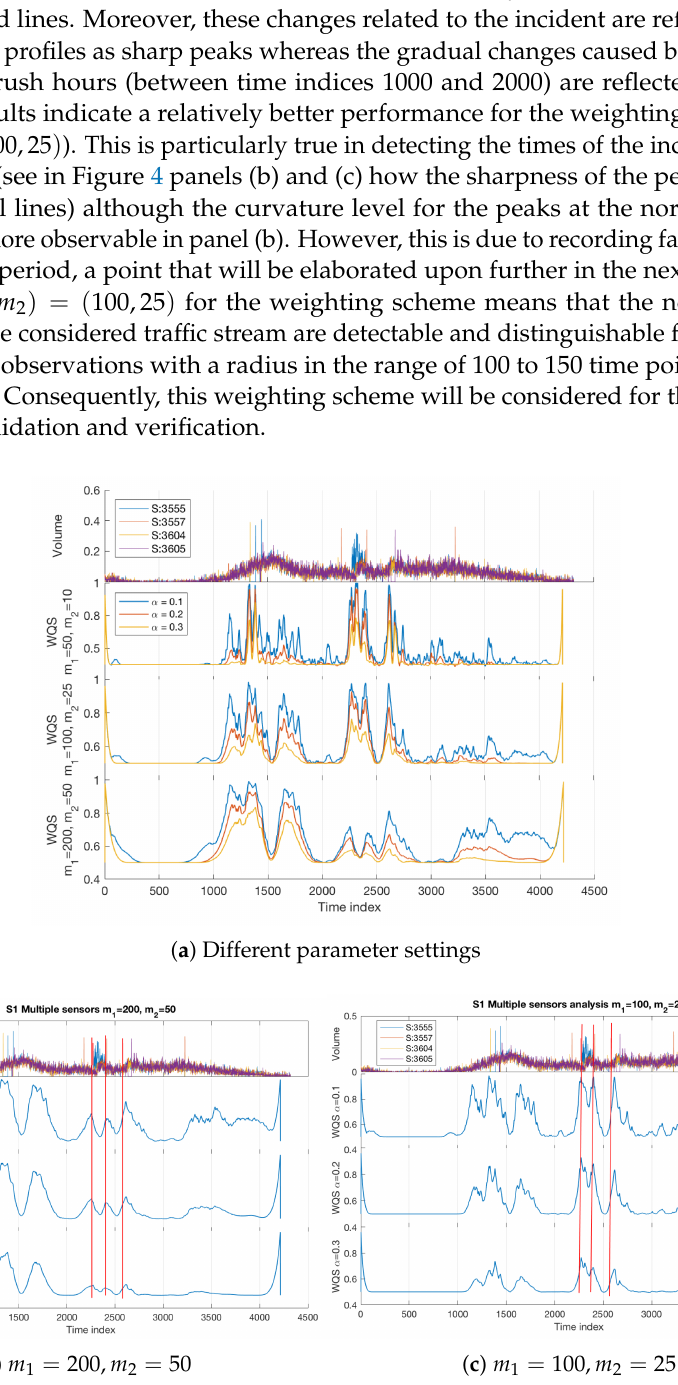
Figure 4. Incident S1 multiple sensor analysis. In panel ( a ), different parameter settings are investi- gated. In panels ( b , c ), the vertical red lines refer to the incident start time, incident end time, and queue end time, respectively (see Table